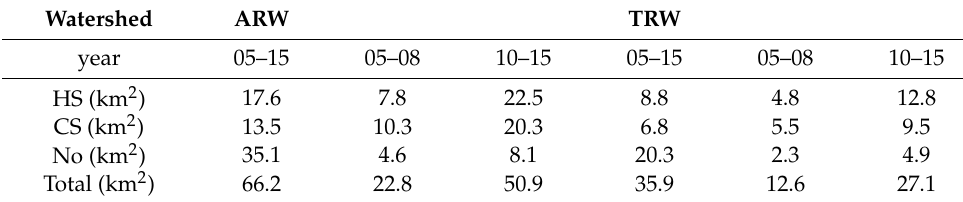
Table 5. The statistical data of spatiotemporal landslide hot spots and cold spots in the ARW and TRW .